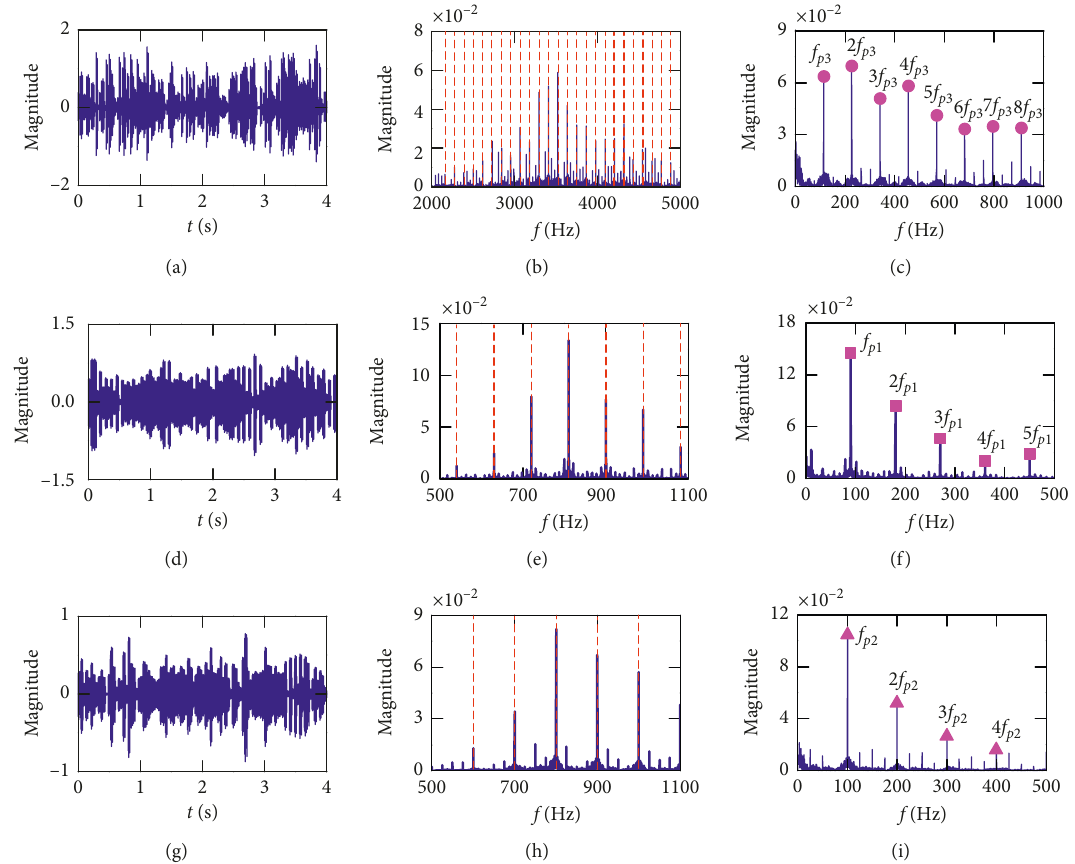
Figure 7: Results obtained by the proposed CPS: (a) periodic impact components from the first IMF; (b) Fourier spectrum of (a); (c) envelope spectrum of (a); (d) first periodic impact components from the third IMF; (e) Fourier spectrum of (d); (f) envelope spectrum of (d); (g) second periodic impact components from the third IMF; (h) Fourier spectrum of (g); (i) envelope spectrum of